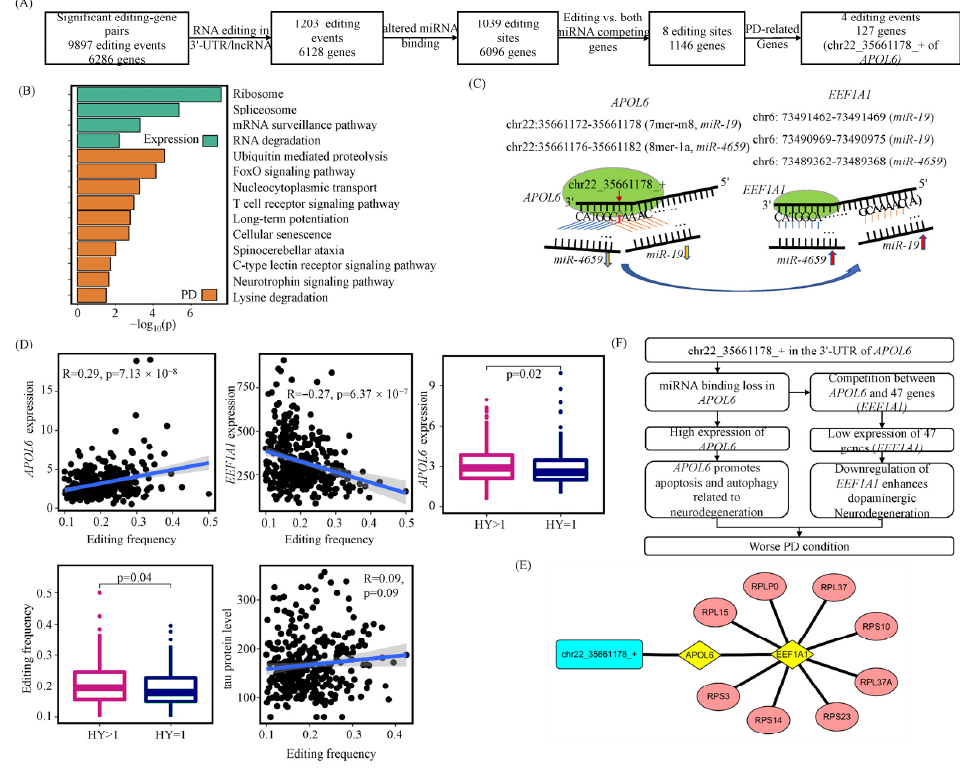
Figure 4. A-to-I RNA editing events may alter miRNA competitions between their host genes and other genes. ( A ) Analysis procedures to uncover one possible mechanism of the trans-associations between RNA editing events and genes. ( B ) The enrichment results of the genes affected by editing- mediated miRNA competitions. ( C ) One RNA editing event in the 3 ′ -UTR of APOL6 causes the binding loss of miRNAs and releases the miRNAs to regulate EEF1A1 . ( D ) The frequency of this editing event is positively associated with the expression of APOL6 and negatively correlated to EEF1A1 . APOL6 is highly expressed in severe PD samples. The editing event has higher frequencies in the samples with increased H&Y stages or tau protein levels. ( E ) The editing event may directly result in the overexpressions of APOL6 and indirectly cause the downregulations of 47 genes in- cluding EEF1A1 and 8 ribosome proteins. ( F ) The potential roles of this RNA editing event related to PD pathogenesis. 3.4. A-to-I RNA Editing Events May Modify miRNA Seed Regions to Disturb Their Regulations Given that miRNA seed regions are highly conserved, a single nucleotide change (e.g., A-to-I RNA editing) can dramatically alter the targeted genes of the miRNAs. In